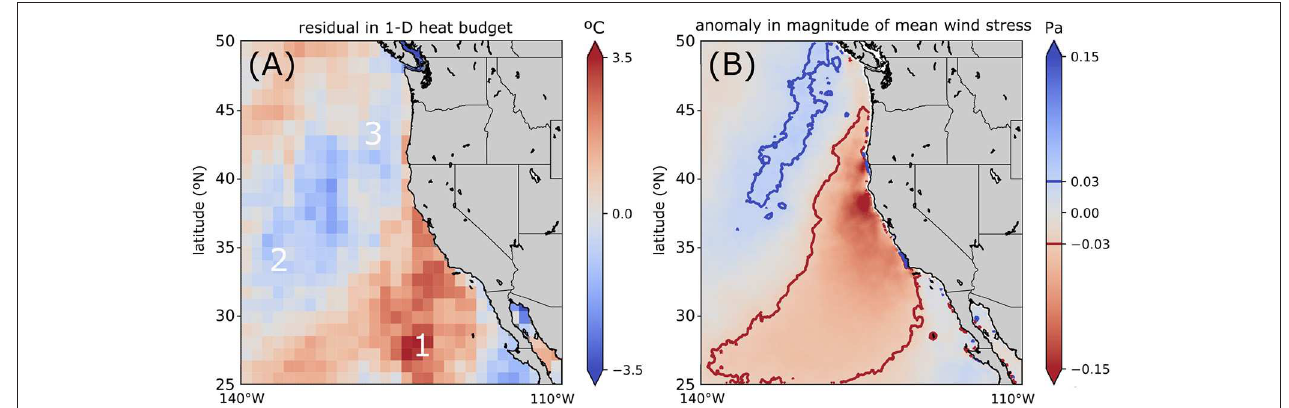
FIGURE 6 | (A) Residual in the 1-D budget for the ocean surface mixed layer heat anomaly during 1–14 July 2015, equal to Figure 4A minus Figure 4B . Red indicates unexplained ocean warming. (B) Anomaly in the magnitude of the mean wind stress during 1–14 July 2015, equal to the magnitude of the arrows in Figure 2B minus the magnitude of the arrows in Figure 2A . Note that in (B) , red indicates weaker mean wind stress, and blue indicates stronger mean wind stress, in 2015 as compared to 2000–2017. This reversed color convention for the wind stress anomaly is to facilitate comparison of the two panels. The are shown as a threshold for a non-negligible wind stress anomaly, following previous studies (e.g., Fewings et al., 2008). White numbers mark regions referred to in section